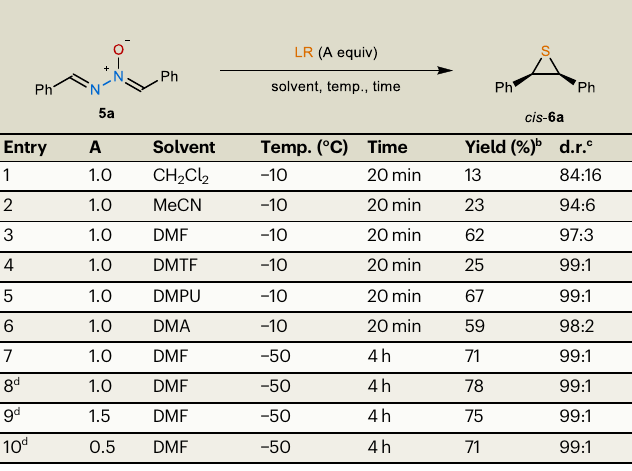
Table 1 | Reaction conditions optimization a